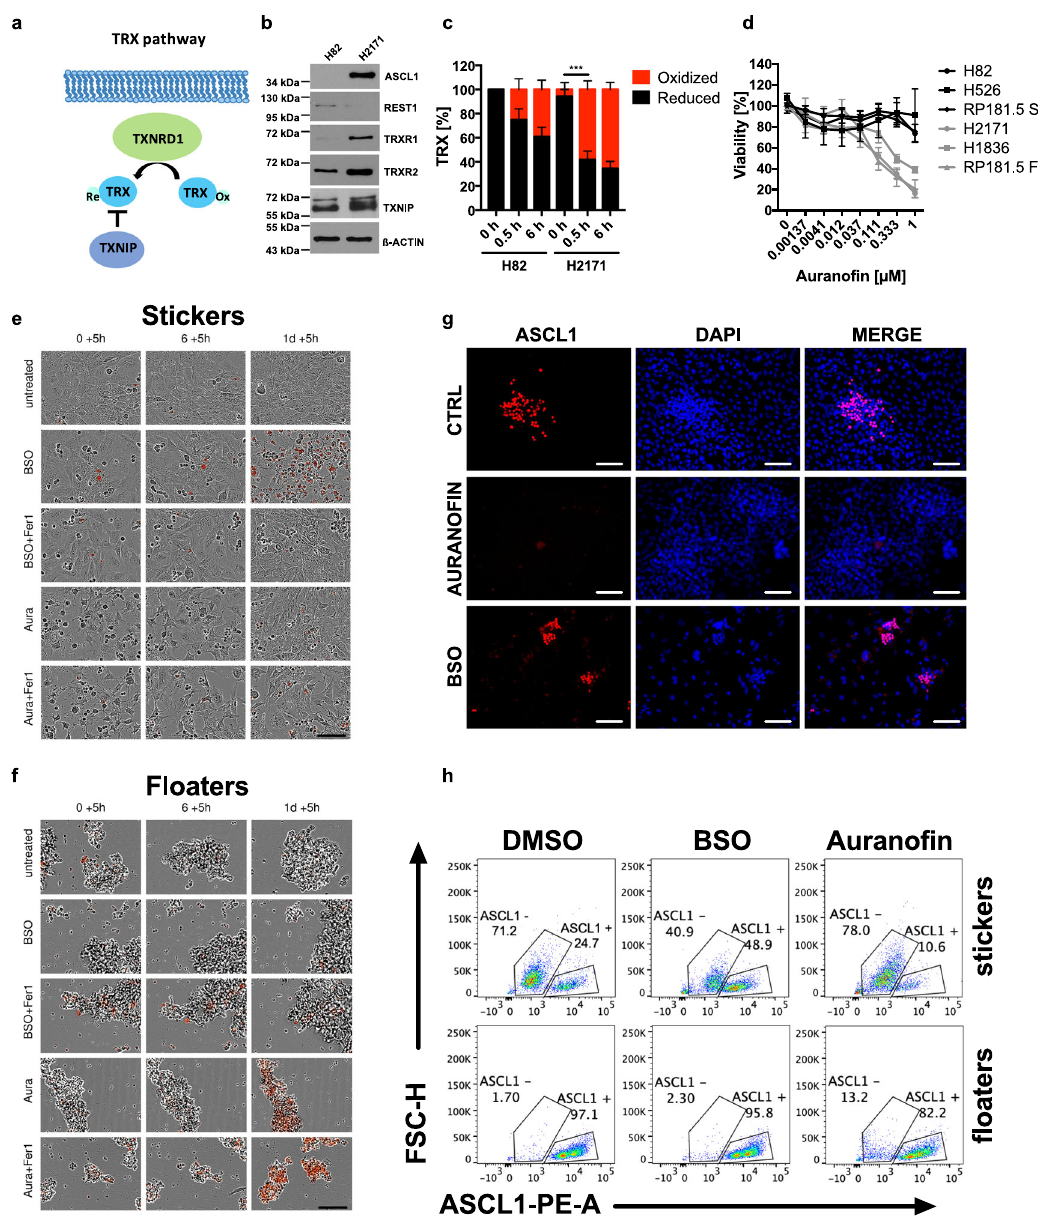
Fig. 5 Neuroendocrine SCLC presents with TRX pathway addiction. a Schematic view of genes involved in the TRX anti-oxidant pathway. b H82 and H2171 cells were lyzed and TRX pathway component expression was detected by western blot. Representative western blots are shown. c Indicated cells were treated with Aurano fi n [1 µ M] for the indicated times and subjected to redox shift assays. Densitometrical quanti fi cation of TRX redox forms is shown. d Indicated cells were treated with Aurano fi n for 24 h, cell viability was determined by Cell Titer Blue. e , f RP181.5 manually separated stickers and fl oaters were treated with Ferrostatin-1 [5 µ M] for 2 h prior to adding DMSO, BSO [10 mM] or Aurano fi n [1 µ M] for an additional 24 h. DRAQ7 [0.1 µ M] (red color in image) was added to all wells to visualize dead cells. Images were acquired every 5 h using the IncuCyte S3 bioimaging platform. Scale bar = 100 µ m. g RP181.5 stickers were treated with either DMSO, Aurano fi n [500 nM] or BSO [500 µ M] for 96 h and then fi xed and stained for ASCL1 (red) and counterstained with DAPI (blue). Scale bar = 100 µ m. h Manually separated stickers and fl oaters were treated with either DMSO, BSO [10 mM] or Aurano fi n [1 µ M] for 24 h. Cells were gated on live cells and analyzed for ASCL1 expression by fl ow cytometry. FSC-H, forward scatter-heights. Data are means ± SEM of three independent experiments or two ( c ) or representative images out of at least two independent experiments are shown. Two-way ANOVA + Tukey ’ s multiple comparison test, *** p < 0.001. Source data are provided as Source data fi